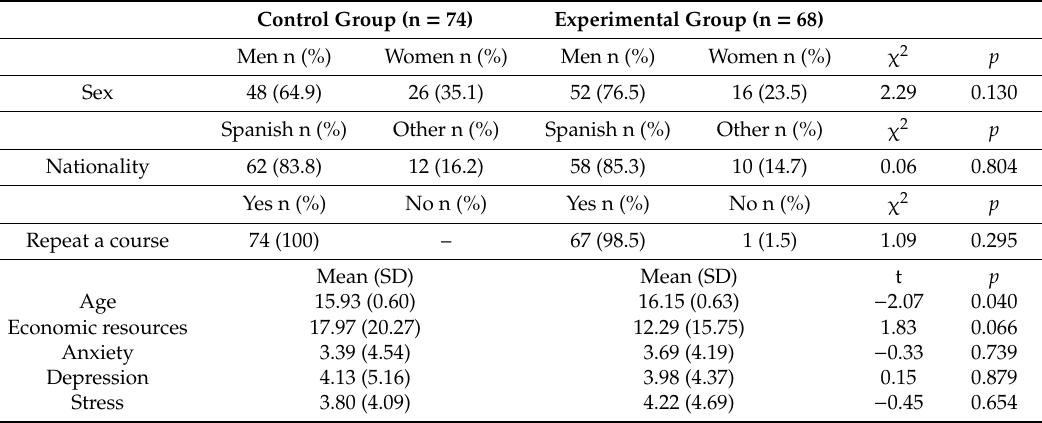
Table 1. Baseline sociodemographic and clinical characteristics of experimental and control